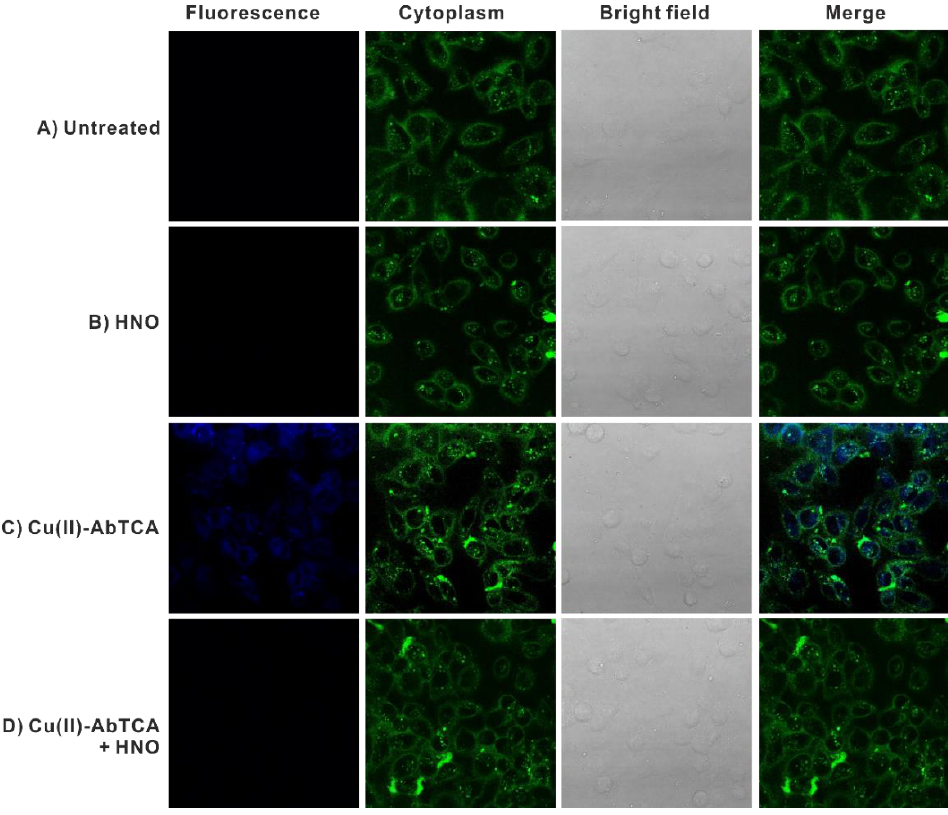
Figure 2. Confocal microscopy images of HNO in live EAHY-44926 cells as detected using Cu(II)-AbTCA (20 µM). Fluorescence images ( left ); Cytoplasm images ( middle ); Bright field images ( middle ); Merged images ( right ). ( A ) EAHY-44926 cells alone; ( B ) Cells treated with Angeli’s salt (200 µM); ( C ) Cells treated with Cu(II)-AbTCA; ( D ) Cells pretreated with Cu(II)-AbTCA followed by Angeli’s salt.